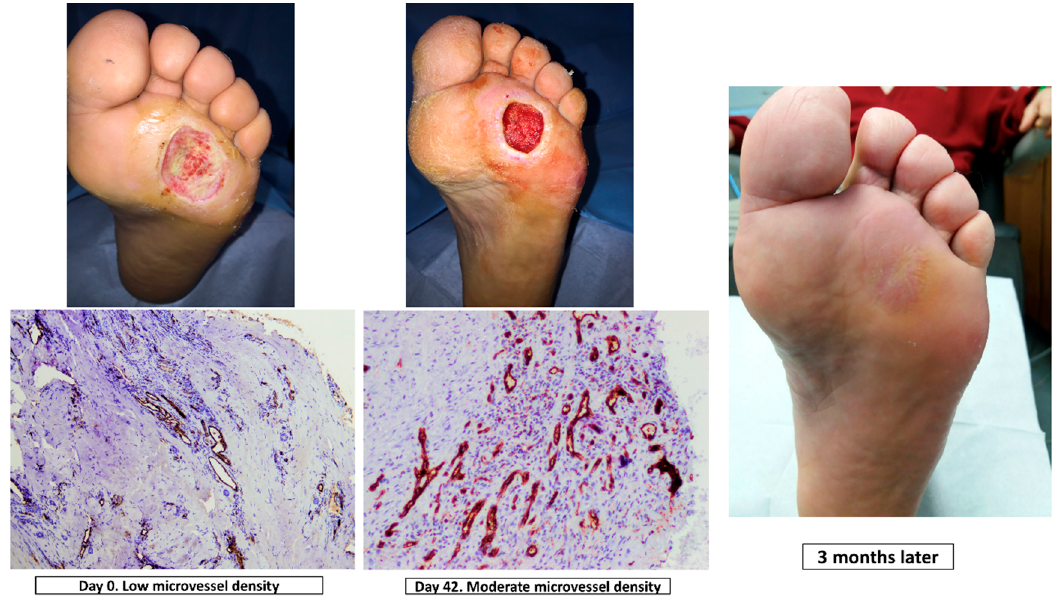
Figure 1. Immunohistochemistry staining of CD31 (magnification, × 10) at day 0 and day 42, clinical situation and progression of healing in a patient of the ultrasound-assisted wound (UAW) debridement group.